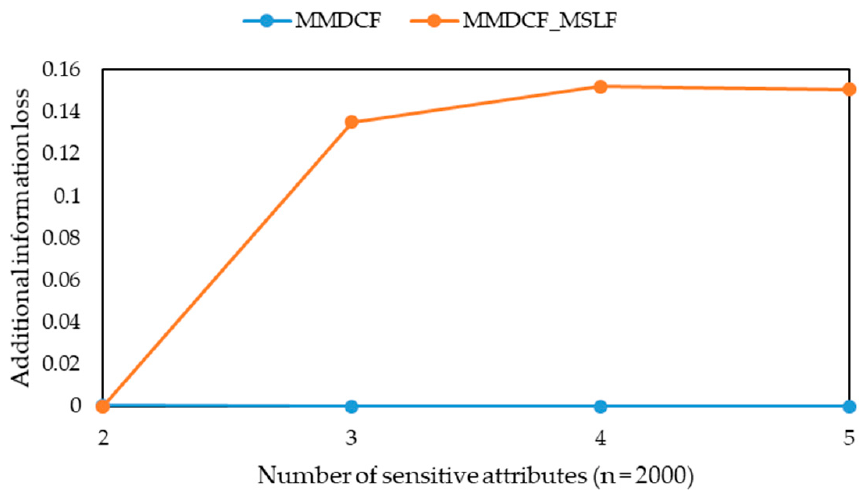
Figure 17. The additional information loss of MMDCF and MMDCF-MSLF with di ff erent sensitive attribute numbers ( n =